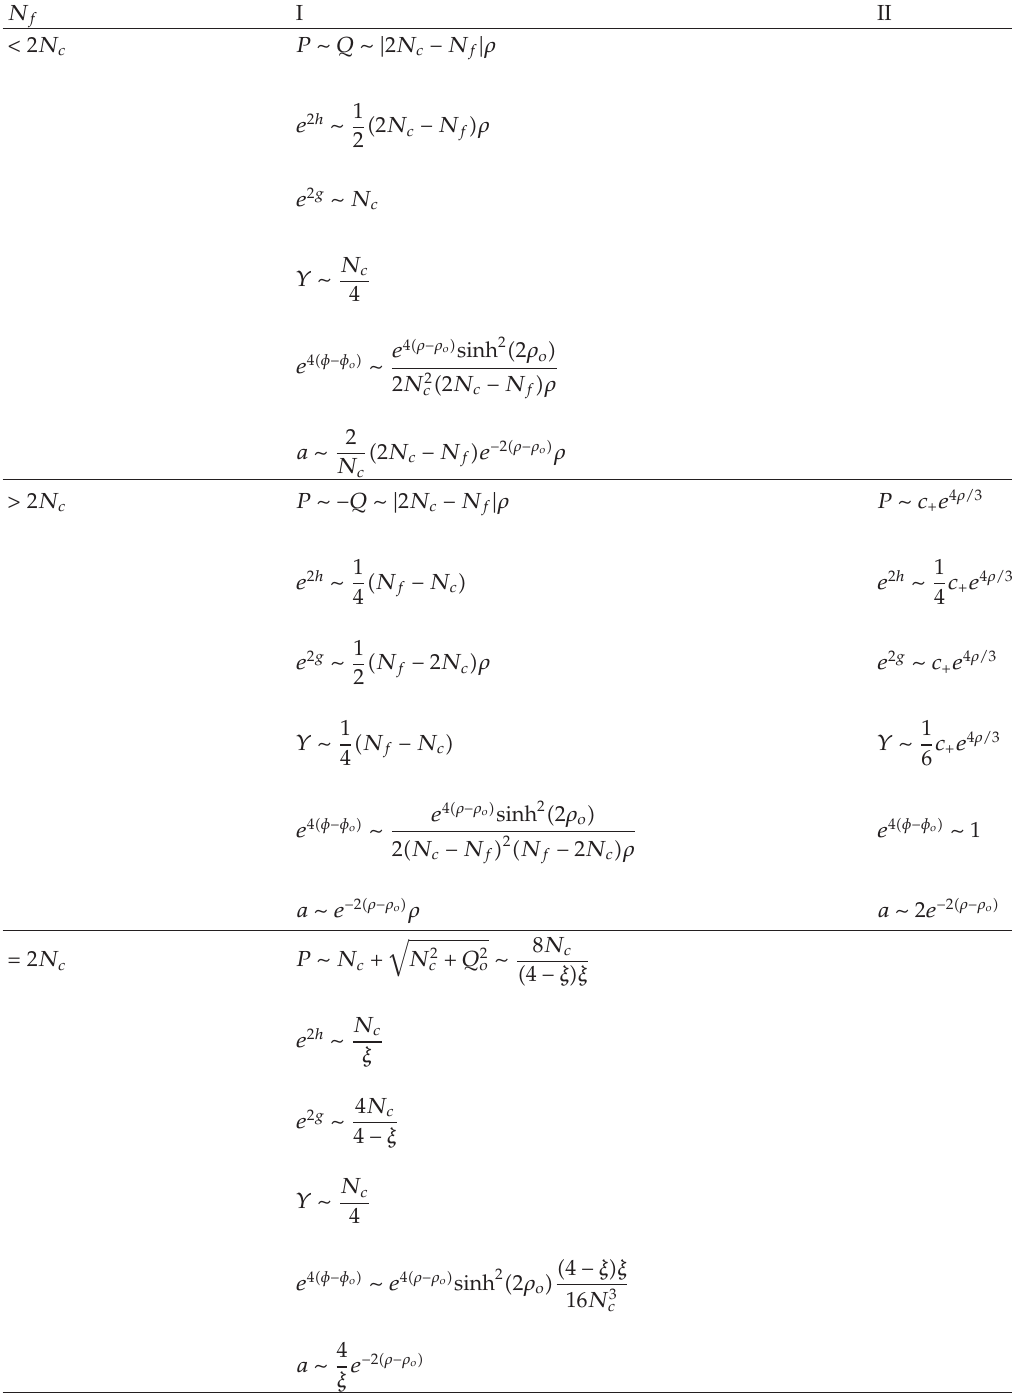
Table 1: The two classes of leading UV behaviors.